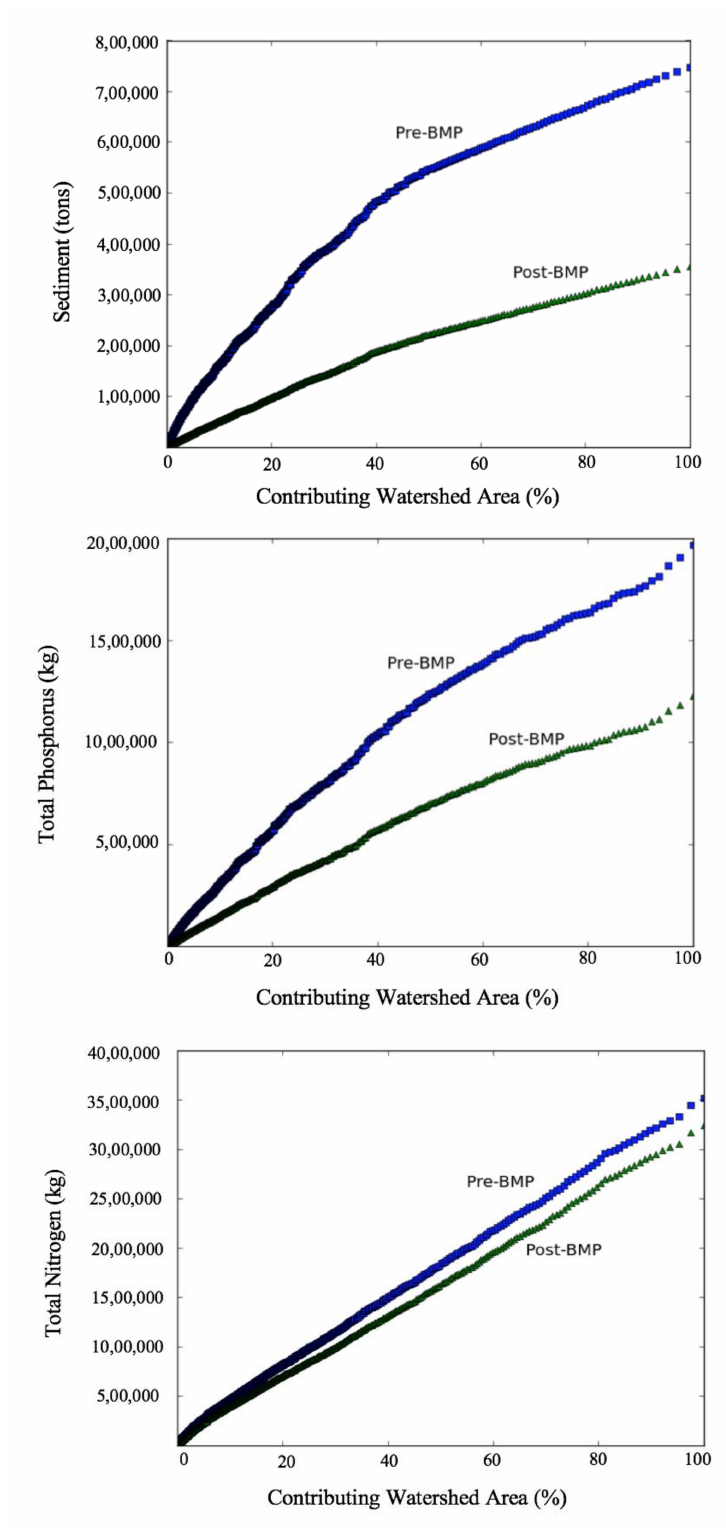
Figure 7. Cumulative sediment ( top ), Total P ( middle ), and Total N ( bottom ) losses by percent of the contributing watershed area for irrigation land leveling